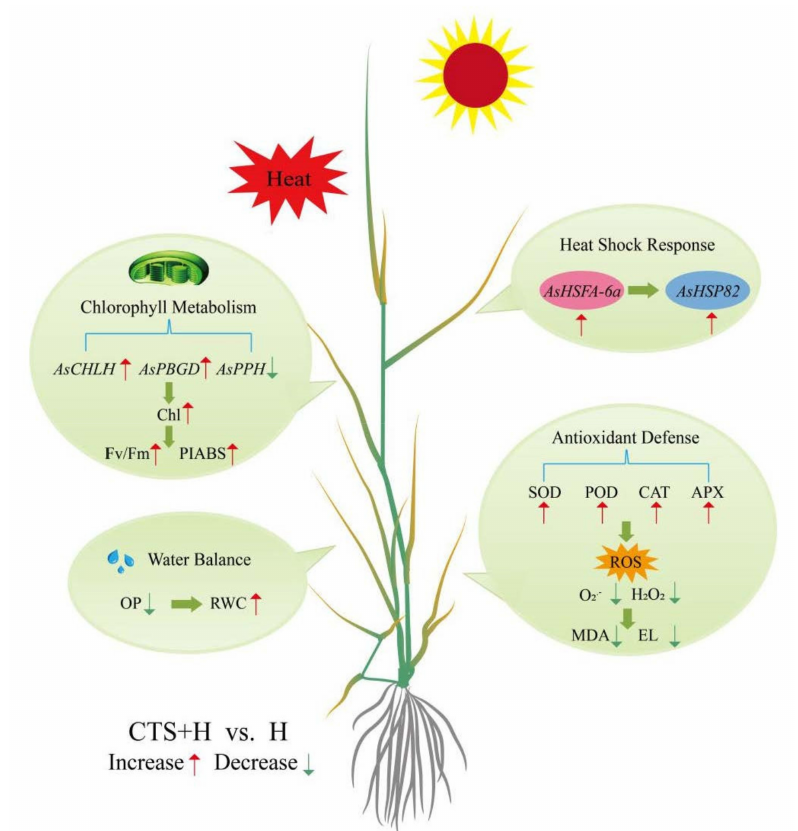
Figure 9. Integrative pathways regulated by chitosan in the leaves of creeping bentgrass under heat